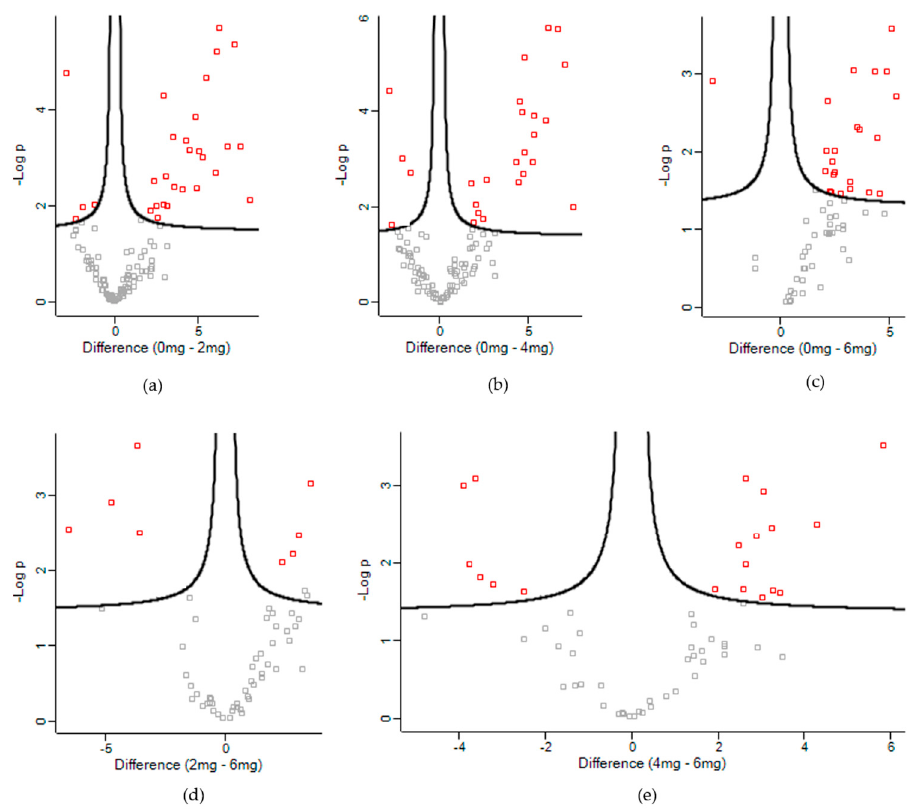
Figure 3. Volcano plots of differentially expressed proteins in: ( a ) Control vs. Low, ( b ) Control vs. Medium, ( c ) Control vs. High, ( d ) Low vs. High and ( e ) Medium vs. High.